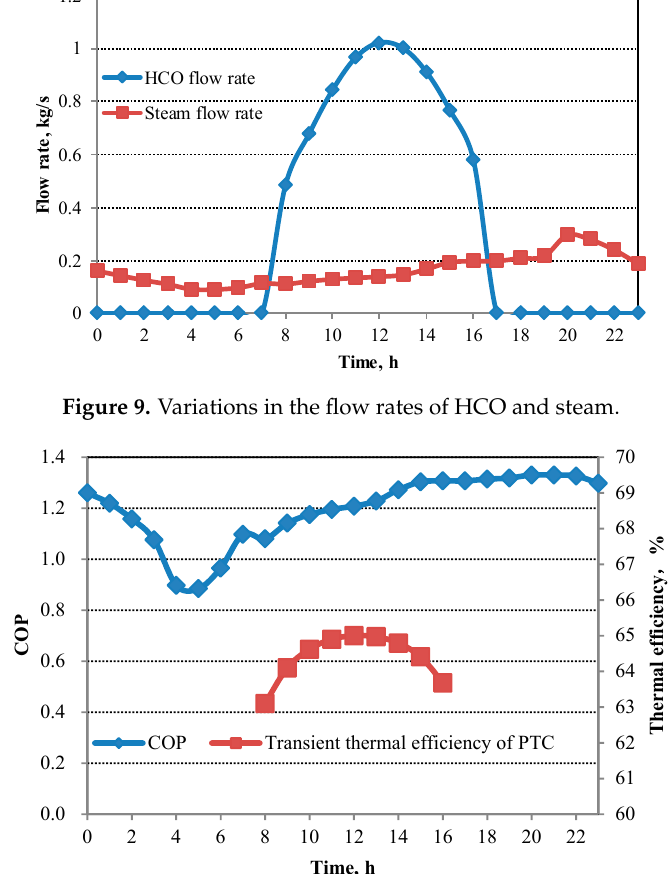
Figure 10. Variations in coefficient of performance (COP) and collecting efficiency of solar collector.